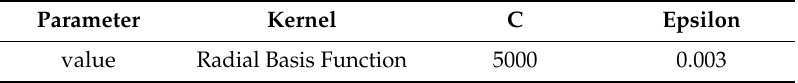
Figure 7. Support vector machine. Table 3. Parameters for support vector regression.